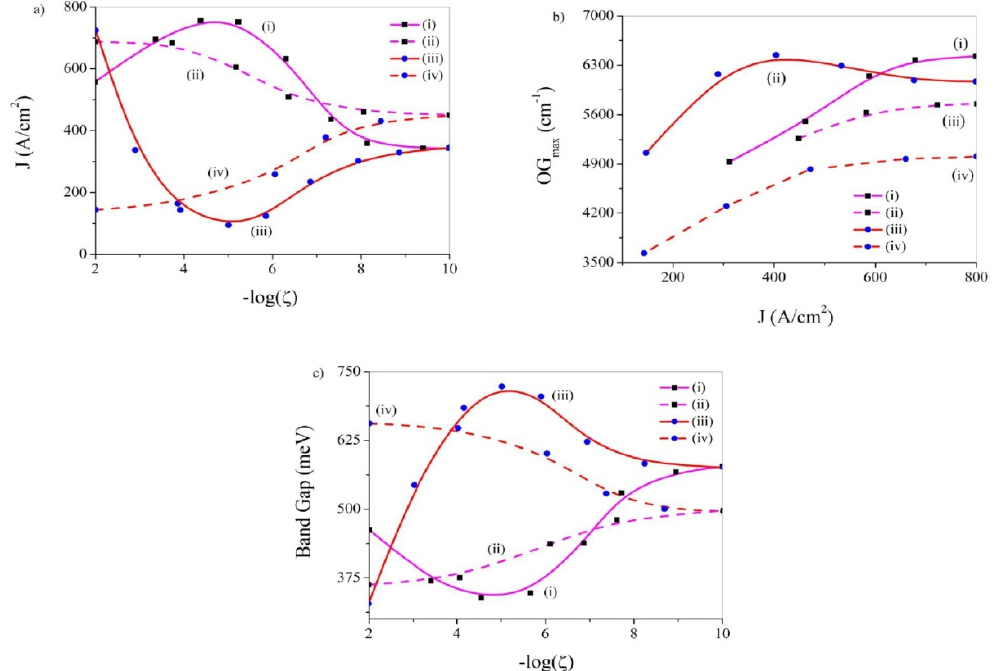
Figure 21. Plots of ( a ) J vs. − log( ζ ), ( b ) OG peak vs. J and ( c ) band gap vs. − log( ζ ): (i) with ADWN and under OPA, (ii) with ADWN and under EPA, (iii) with MLWN and under OPA and (iv) with MLWN and under EPA.